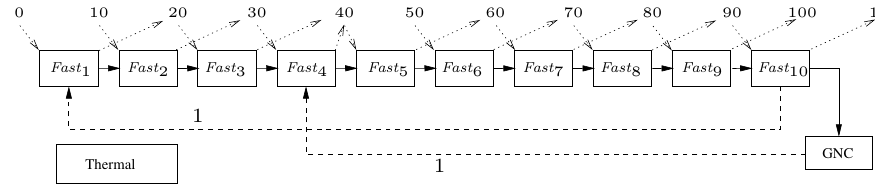
Figure 8 Adding 3-place circular buffer constraints to our